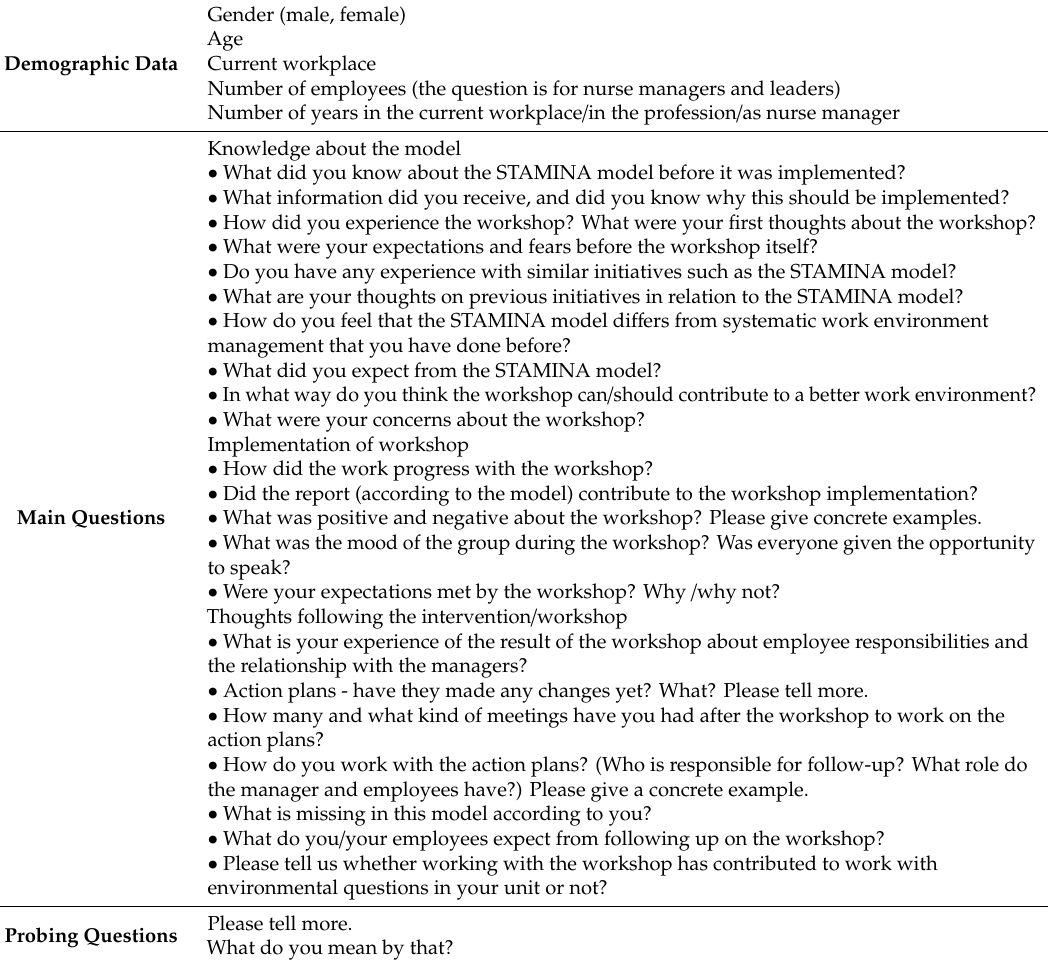
Table 1. The interview